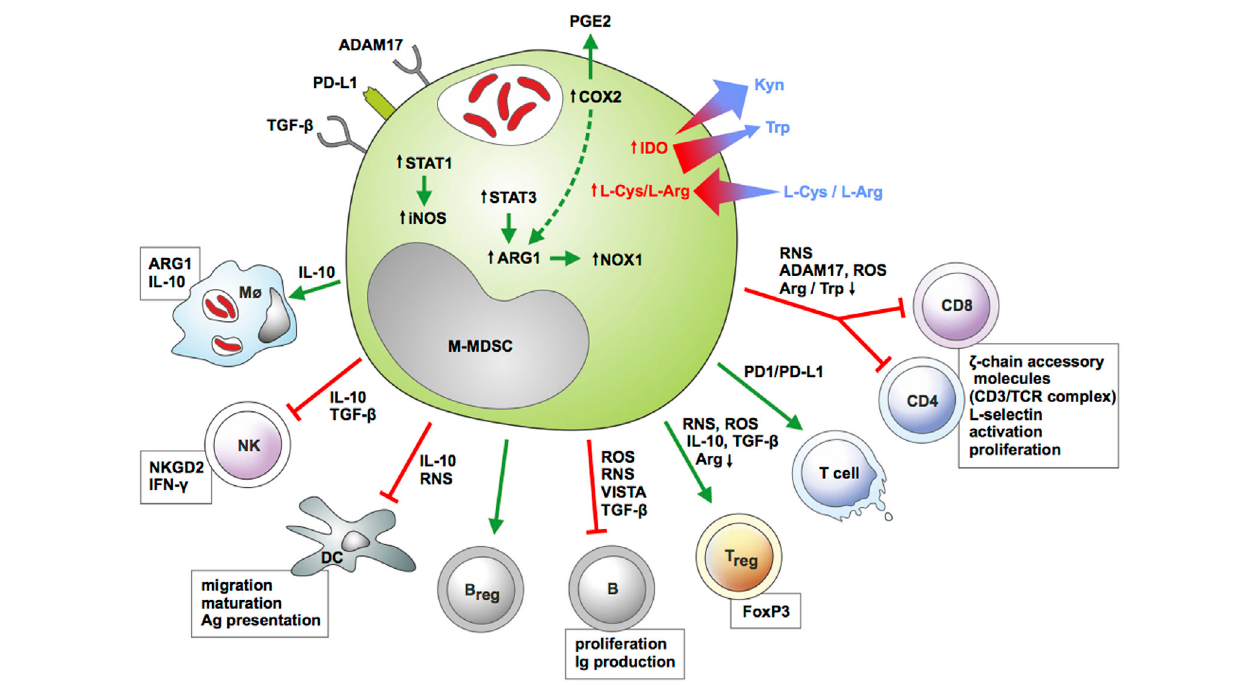
FiGURe 2 | Features of monocytic myeloid-derived suppressor cells (M-MDSC) and their interactions with immune cells during infection. M-MDSC express membrane-bound inhibitory receptors and upregulate enzymatic pathways [inducible nitric oxide synthase (iNOS), ARG1, COX2, IDO] conferring suppressive activity toward multiple myeloid and lymphoid cell subsets. The key function of M-MDSC is suppression of T-cell immunity. M-MDSC restrict proliferation and release of cytokines by effector CD4 and CD8 lymphocytes and induce apoptotic cell death in these cells. In addition, these myeloid regulatory cells induce regulatory T and B cells, while limiting antibody release and proliferation of conventional B cells. M-MDSC alter activity of NK cells and antigen-presenting cells (APCs) and induce polarization of macrophages toward a regulatory phenotype. Color-coded arrows indicate induction/activation (green) or suppression (red), and molecules employed by M-MDSC for such effects are highlighted. Size- and color-coded arrows indicate gradient fluxes for selected essential amino acids. Boxes indicate cellular functions or pathways modulated by M-MDSC. Abbreviations: ADAM17, ADAM metallopeptidase domain 17; ARG1, arginase 1; CD, cluster of differentiation; COX2, cyclooxygenase 2; DC, dendritic cell; IDO1, indoleamine dioxygenase 1; IFN- γ , interferon gamma; IL-10, interleukin 10; iNOS, inducible nitric oxide synthase; Kyn, kynurenine; l -Arg, l -arginine; l -Cys, l -cysteine; M Φ , macrophage; NK, natural killer cell; NKGD2, killer cell lectin like receptor K1; NOX1, NADPH oxidase 1; PGE2, prostaglandin E2, PD-L1, programmed-death ligand 1; RNS, reactive nitrogen species; ROS, reactive oxygen species; STAT, signal transducer and activator of transcription; TGF- β , transforming growth factor beta; Trp, tryptophan; VISTA, V-domain Ig suppressor of T-cell